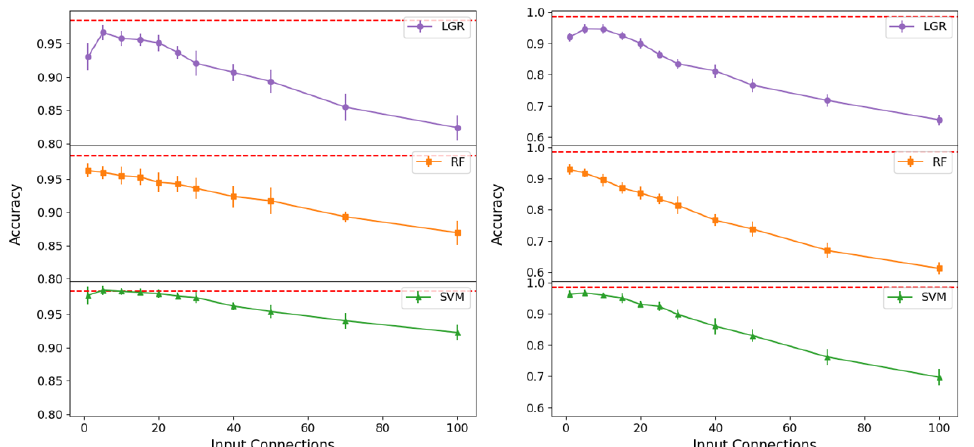
Figure 16. Dop-NET: Graphs of the accuracy vs. varying C inp using 10-fold cross-validation. Results are for an LSM with 960 neurons using logistic regression, random forest, and support vector machine. The red line indicates accuracy at 98.5%. The left graph shows the results when the spike time of each sample is normalized to a common stimulus length. While the right graphic when each sample has a stimulus length equivalent to the sample time duration.